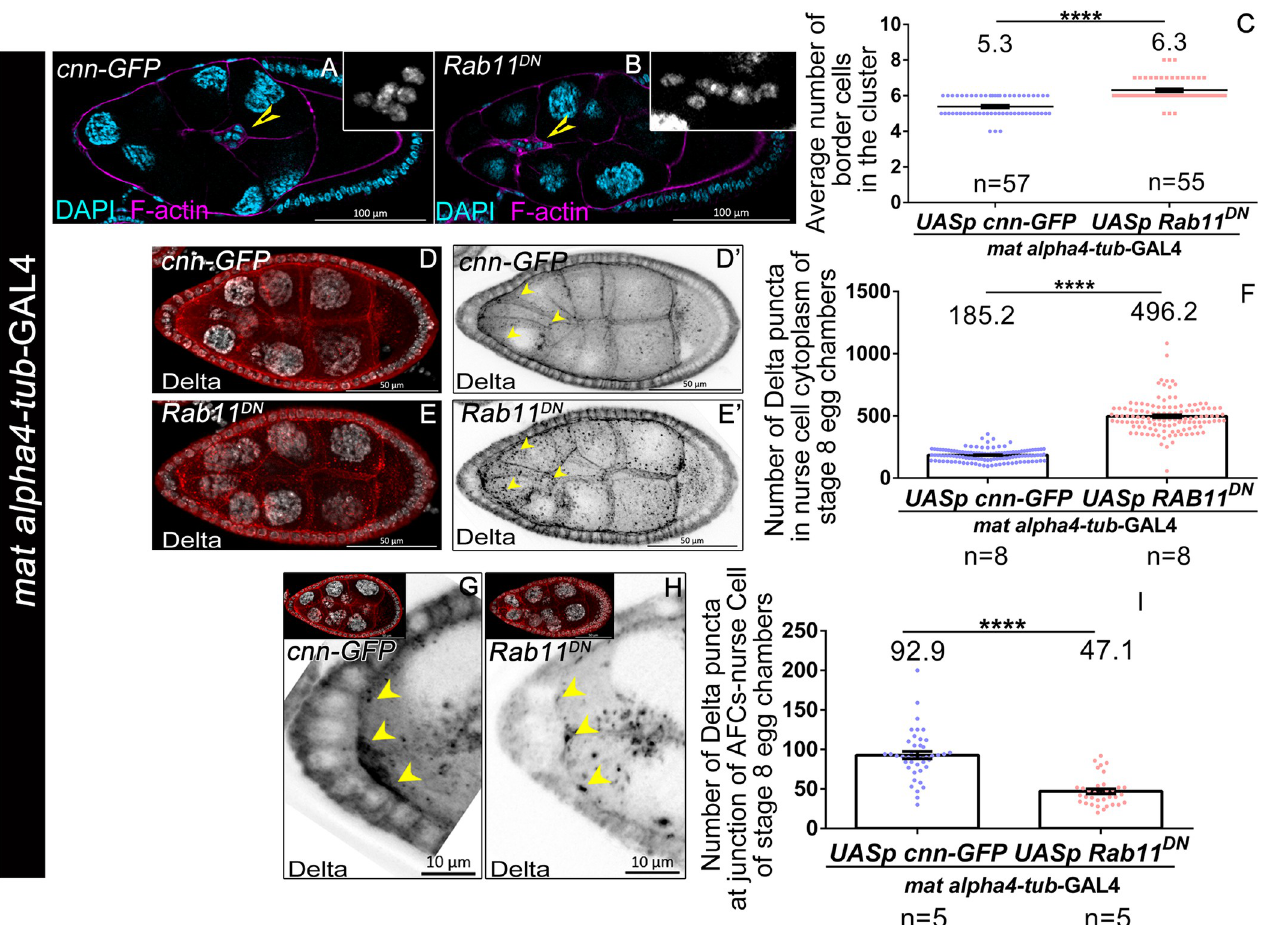
Fig 6. Rab11 function in the germline modulates Delta Trafficking and Border cell specification from the follicle cells. (A-C) Downregulation of Rab11 activity by over-expressing Rab11 DN in the nurse cells results in increased Border cell count compared to control ( mat alpha4-tubulin- GAL4; UASp-cnnGFP ). Yellow arrow heads mark border cell cluster, F-actin (magenta), DAPI (cyan, grey in inset). (D-F) Overexpression of Rab11 DN in nurse cells using mat alpha4-tubulin- GAL4 exhibits cytoplasmic Delta puncta (yellow arrows), Delta (red) in D and E, Delta (black) in D’ and E’. DAPI (blue), GFP (green). (G-I) Overexpression of Rab11 DN in the nurse cells with mat alpha4-tubulin- GAL4 exhibits reduced Delta puncta at the junction of anterior follicle cells and nurse cells, Delta (black, red in inset), DAPI (grey in inset). ���� indicates a p value < 0.0001 (Student t-test). n represents the number of egg chambers evaluated in each